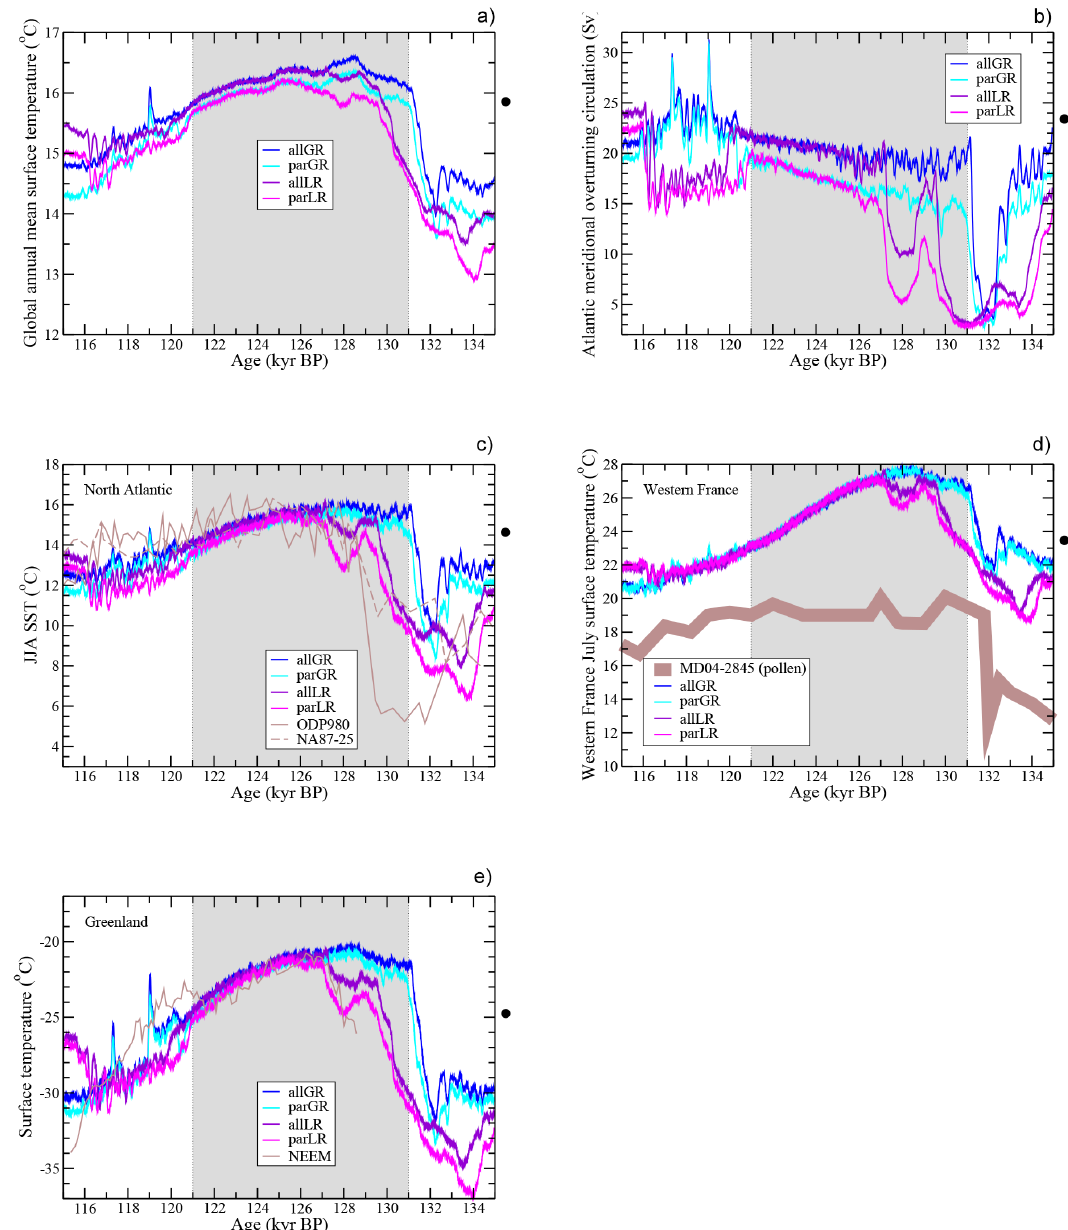
Figure 13. Comparison between the LIG climate simulated using different parameter sets (see text and Table 1) and different Northern Hemisphere ice sheet evolutions (see text and Table 1), and the reconstructed climate. Time evolution of (a) global annual mean surface temperature ( ◦ C); (b) maximum of the meridional overturning stream function in the North Atlantic from model simulations using different surface boundary conditions; (c) NE Atlantic summer SST ( ◦ C) (ODP 980; 55.8 ◦ N, 14.11 ◦ W, Oppo et al., 2006; NA87-25; 55.57 ◦ N, 14.75 ◦ W, Cortijo et al., 1994); (d) July surface temperature over western France (MD04-2845; 45 ◦ N, 5 ◦ W; Sánchez Goñi et al., 2012); and (e) Precipitation-weighted temperature reconstruction corrected for elevation change at the NEEM site, Greenland (77.45 ◦ N, 51.06 ◦ W) (NEEM community members; 2013). The simulated series are smoothed using a moving average over 100yr and averaged over four adjacent grid cells. NA87-25, ODP980 and NEEM records are displayed here on the recent AICC2012 chronology (Capron et al., 2014; Bazin et al., 2013). The black dot on the right hand side of the figures provides the corresponding simulated pre-industrial value. The “plateau” is shaded in grey. The location of the marine and ice cores is provided in Fig. 6 and in Table